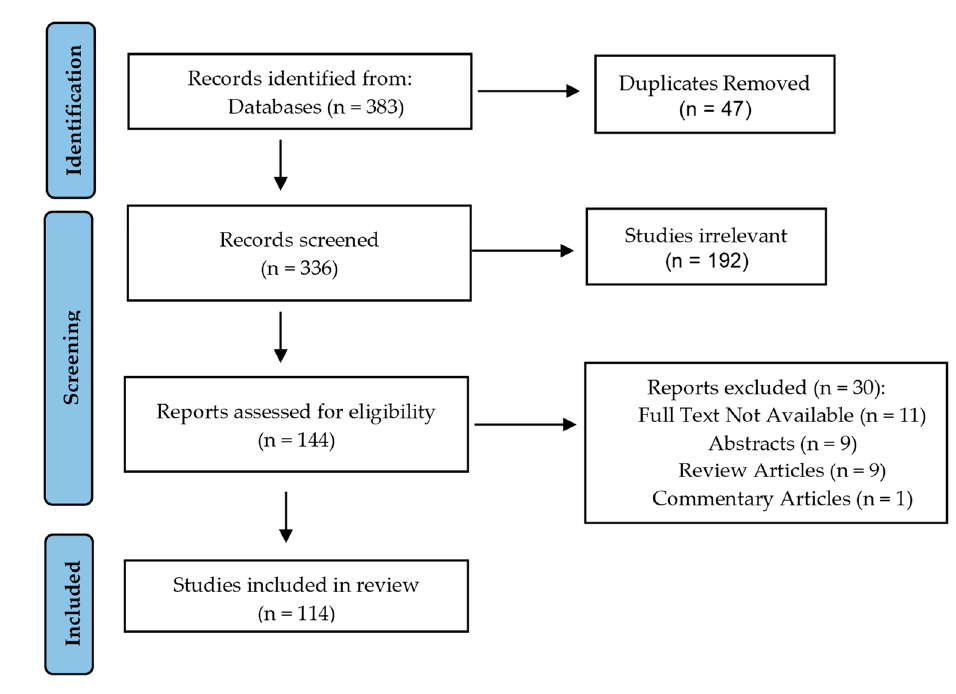
Figure 2. PRISMA guideline literature search.